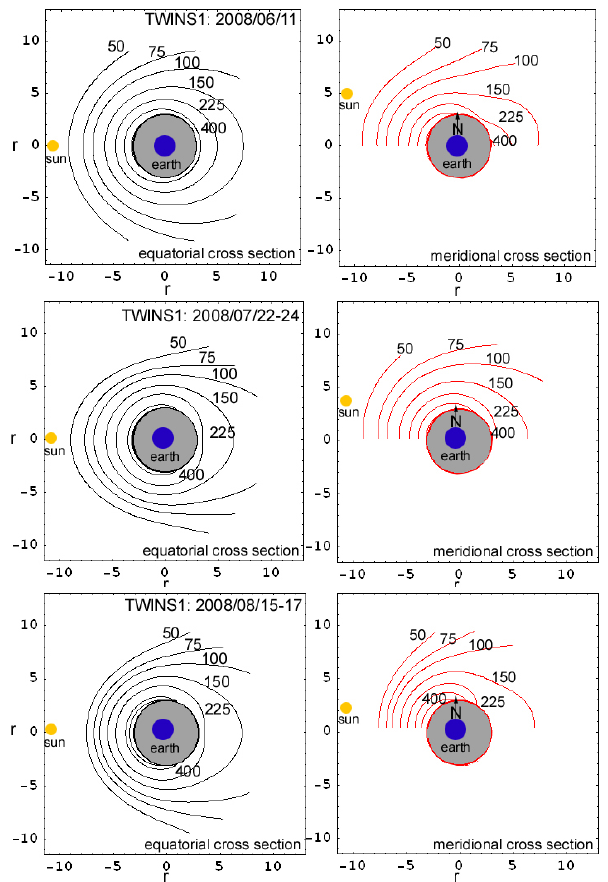
Fig. 6. 3-D-fitted H-density profiles of the geocorona (contours are showing H-density in cm − 3 ) as equatorial cross section (left, black) respectively meridional cross section along the pole axis (right, red) for 3 different dates between June and August 2008. The grey area around the earth shows the optical thick region with geocentric dis- tances r < 3 R E